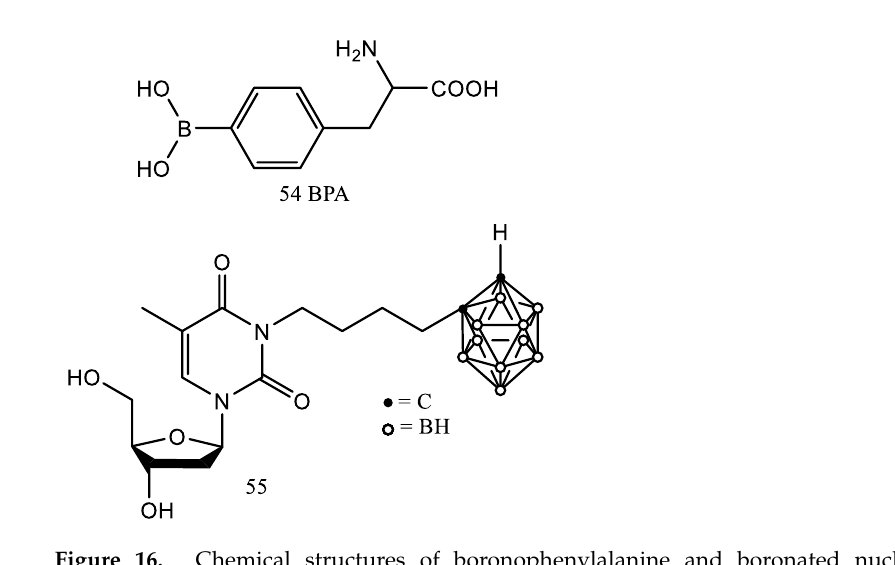
50 H 36 O 12 B,[M] at m / z 839).